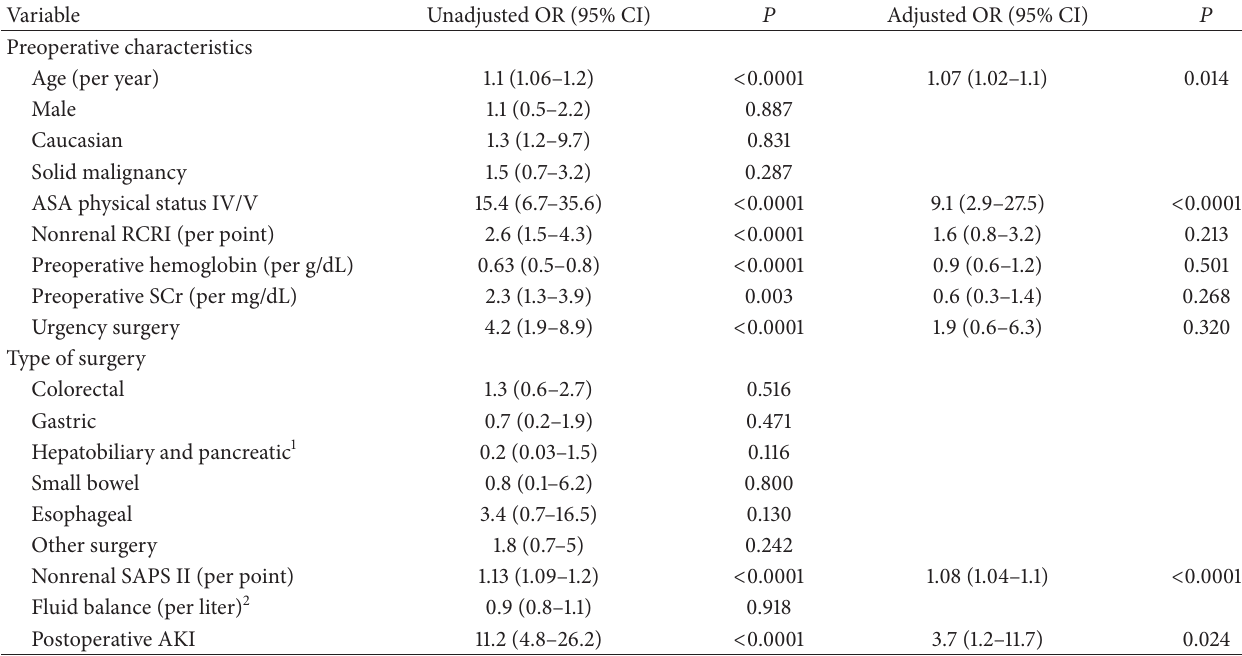
Table 5: Univariate and multivariate analysis to determine predictors of in-hospital